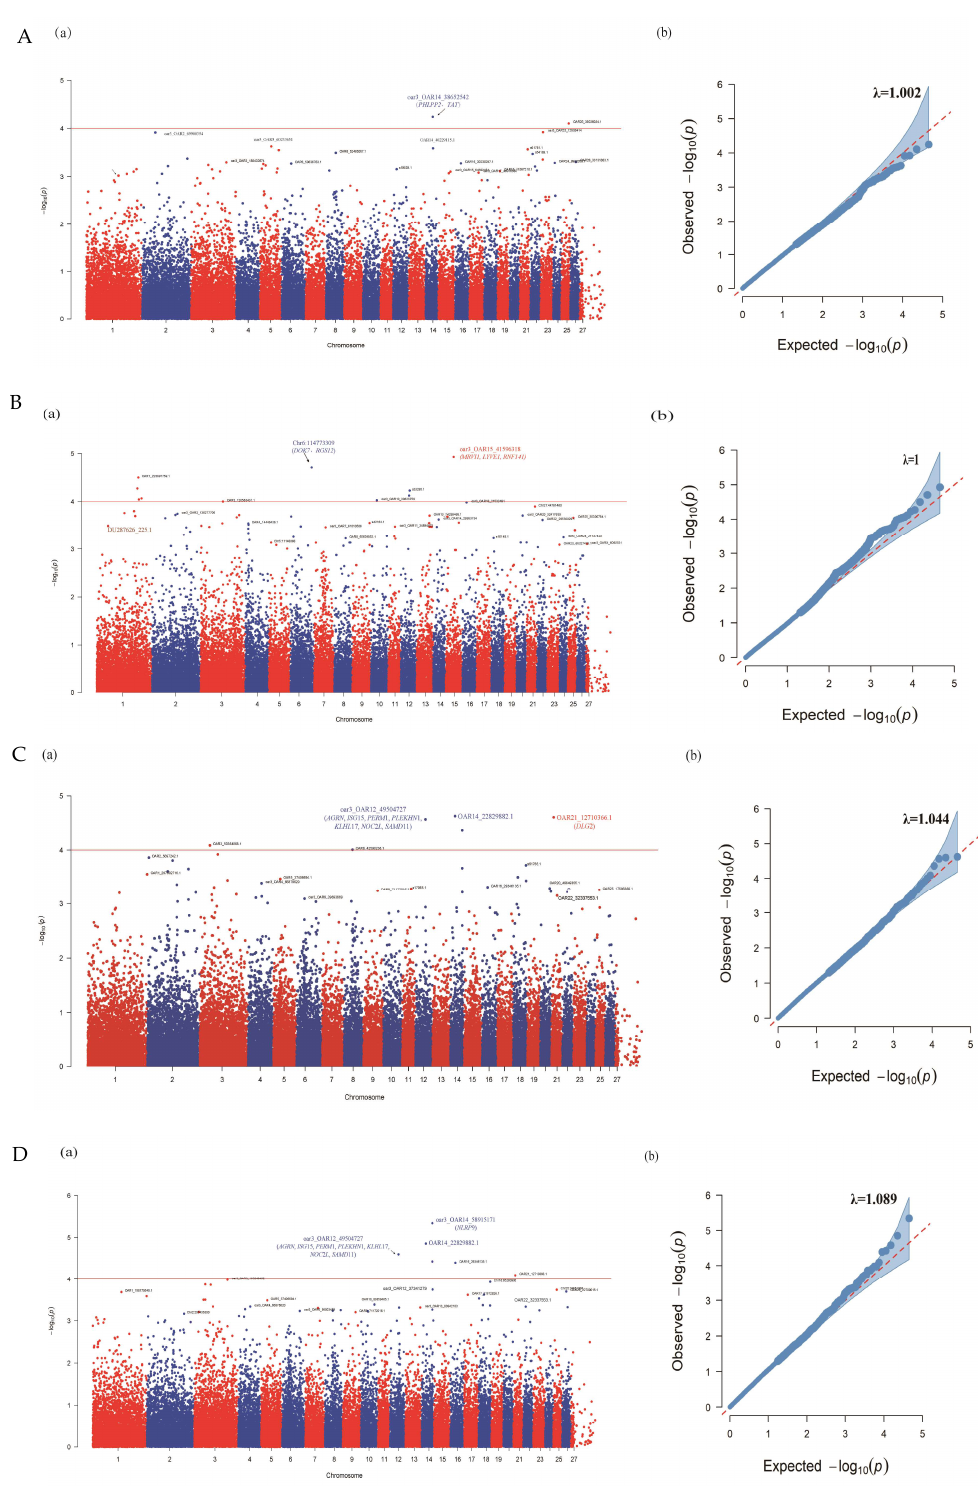
Figure 3. Manhattan and quantile–quantile (Q-Q) plot to SNPs associated with traits on the ovine chromosome. ( A ) LS; ( B ) BWT; ( C ) WWT; ( D ) ADG. ( a ) Manhattan plots X-axis are SNPs positions on chromosomes, Y-axis is -Log10 p . The red line corresponds to the threshold for p < 10 − 4 statistically suggestive significance. ( b ) Q-Q plots of the traits drawn by the expected P and observed p of each SNP.